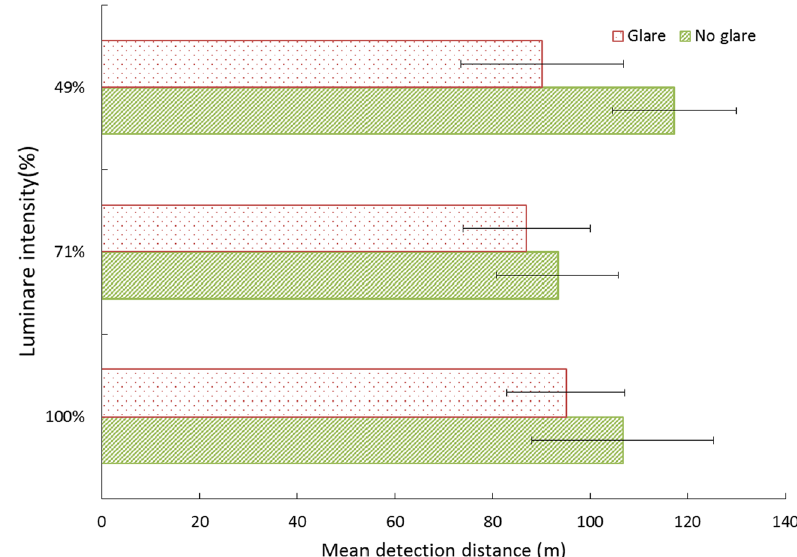
Fig. 3 The mean detection distance of all drivers